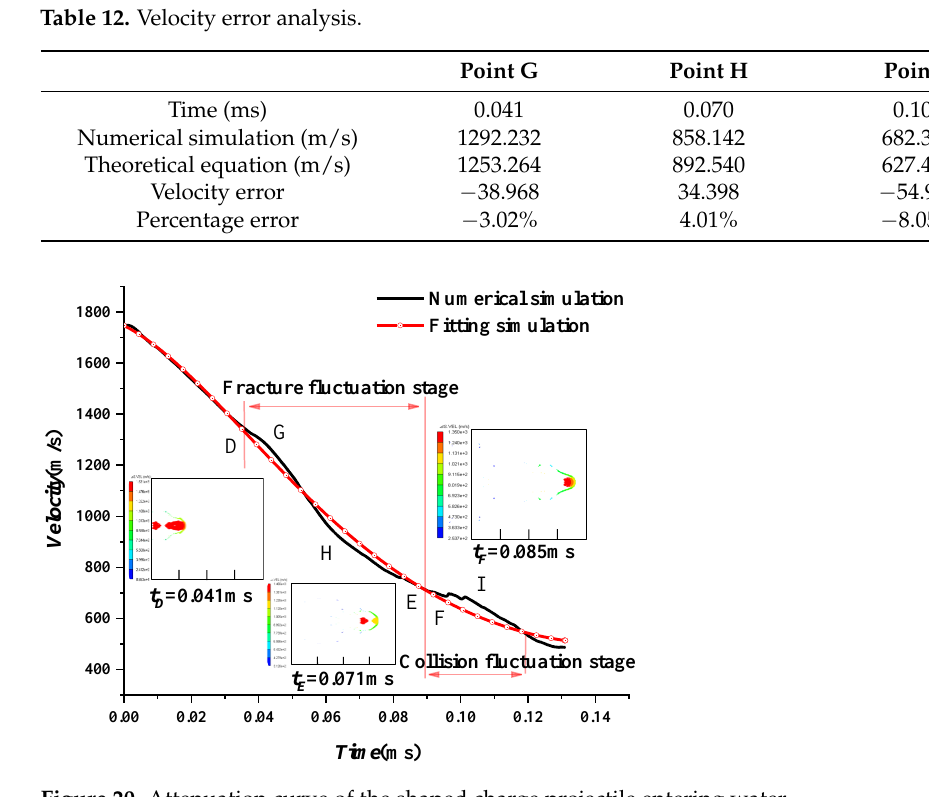
Table 12. Velocity error analysis.